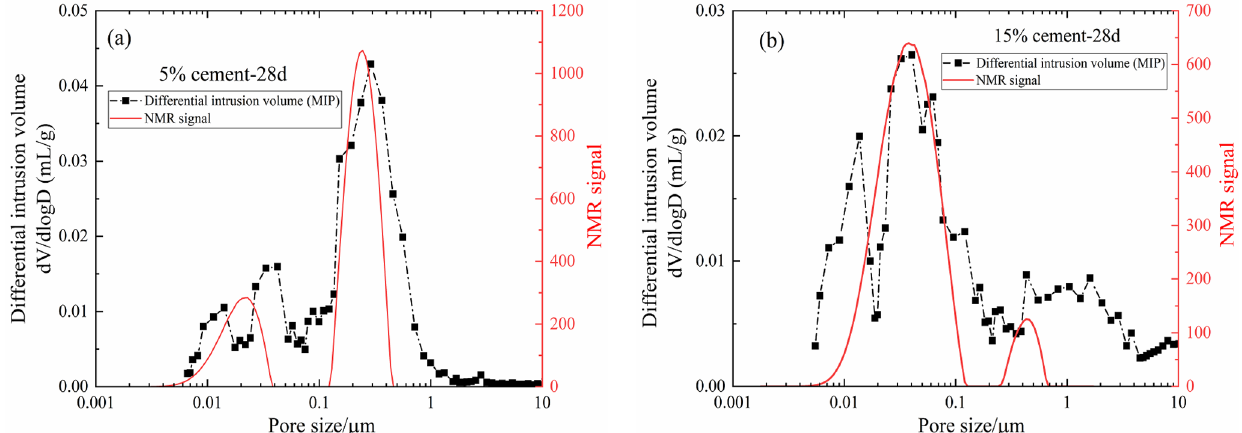
Figure 10. Comparison of MIP and NMR experimental results of specimens cured for 28 days: ( a ) 5% cement content, ( b ) 15% cement content